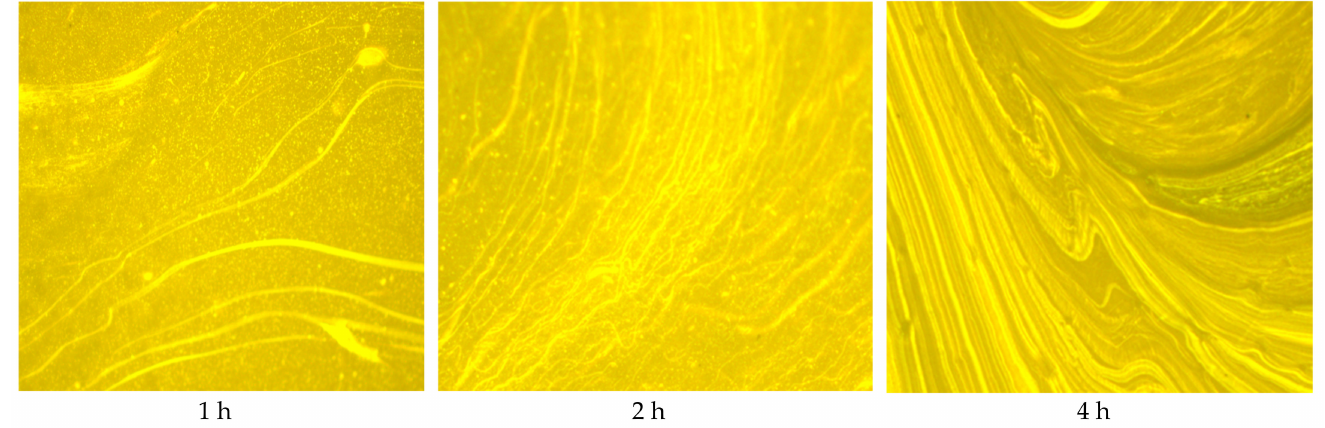
Figure 7. Fluorescence microscopy test of SBS-modified asphalt with different shearing times (100 times).